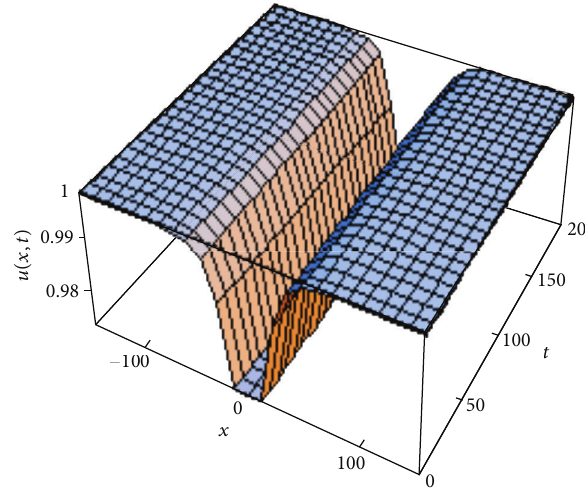
Figure 2: Approximate solution of FWBK equation.